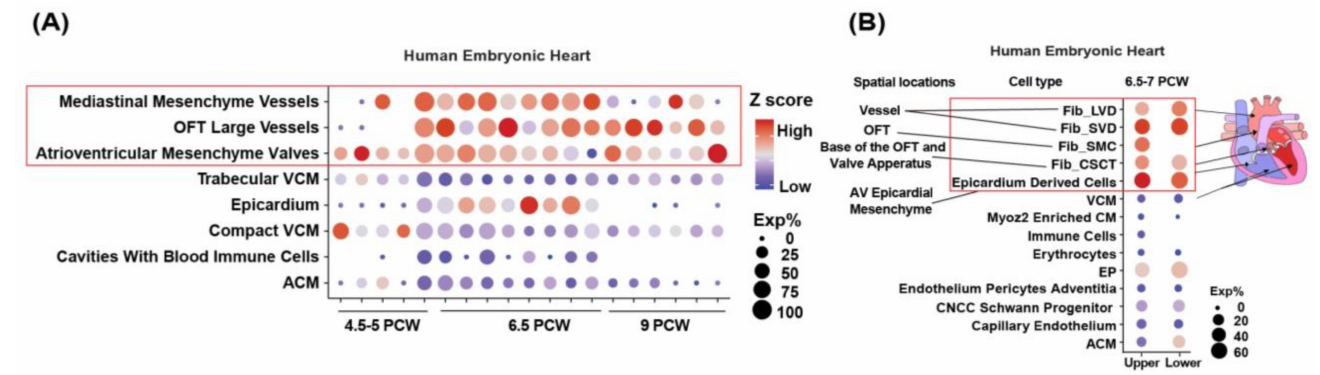
Figure 2. Spatiotemporal expression of LRP1 in the human developing heart. ( A ) Spatiotemporal transcriptional expression of LRP1 in each cluster in each heart section at each developmental stage (from Asp et al., 2019; a total of 3115 spots [5]). PCW-post-conception weeks. The size of the dot indicates the proportions of cells expressing a certain gene in the respective cell (Exp%), and the color stands for the average expression level of that gene within a cluster in z-scored units at each developmental stage (Z score). ( B ) Cellular expression of LRP1 in the human embryonic heart at 6.5 PCW (from Asp et al., 2019; a total of 3717 cells [5]). Upper and Lower stands for the upper and lower parts of the heart, respectively. Fib_LVD-Fibroblast-like related to larger vascular development. Fib_SVD-Fibroblast-like related to smaller vascular development. Fib_SMC-Fibroblast- like smooth muscle cell. Fib_CSCT-Fibroblast-like related to cardiac skeleton connective tissue. ACM-atrial cardiomyocyte, AV-atrioventricular, CM-cardiomyocyte, CNCC-cardiac neural crest cell, EP-epicardial cells, OFT-outflow tract, VCM-ventricular